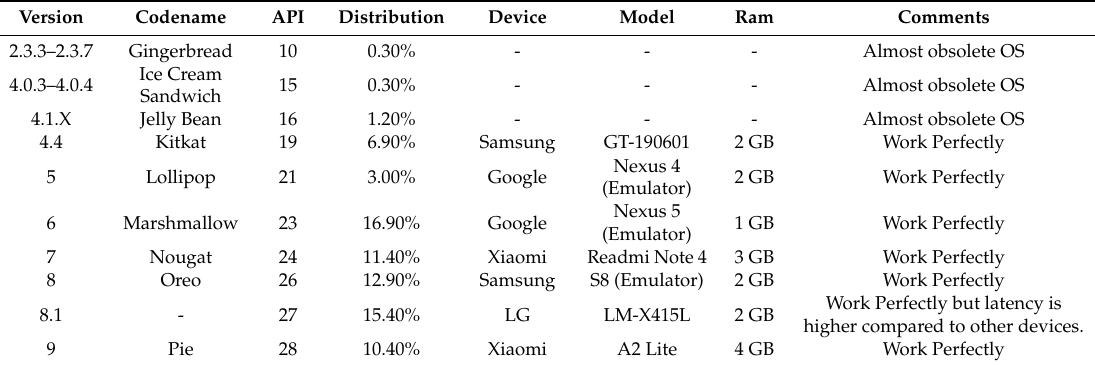
Table 6. Compatibility of developed model in di ff erent